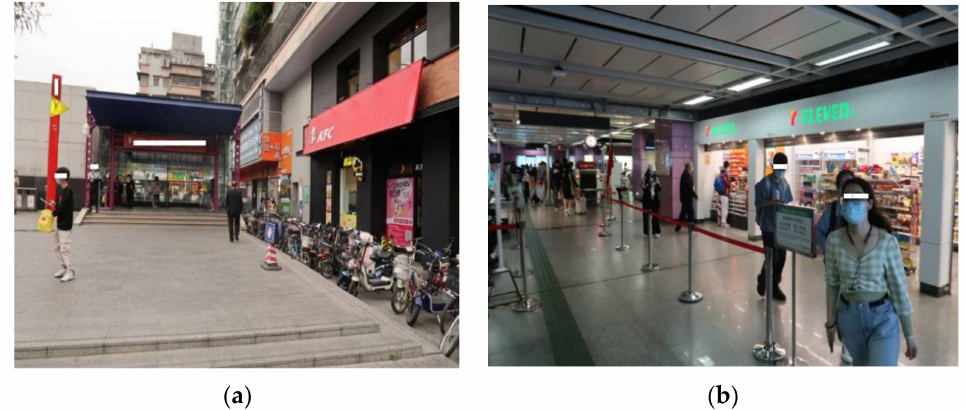
Figure 1. Facilities related to the subway station: ( a ) near the subway station entrance; ( b ) inside the station (underground).